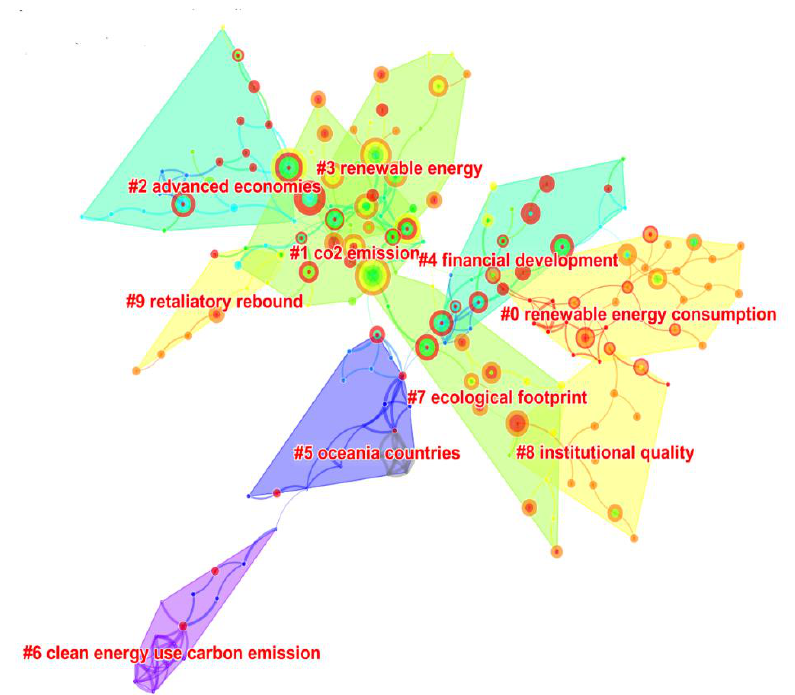
Figure 9. A landscape view of the co-citation network (by CiteSpace).